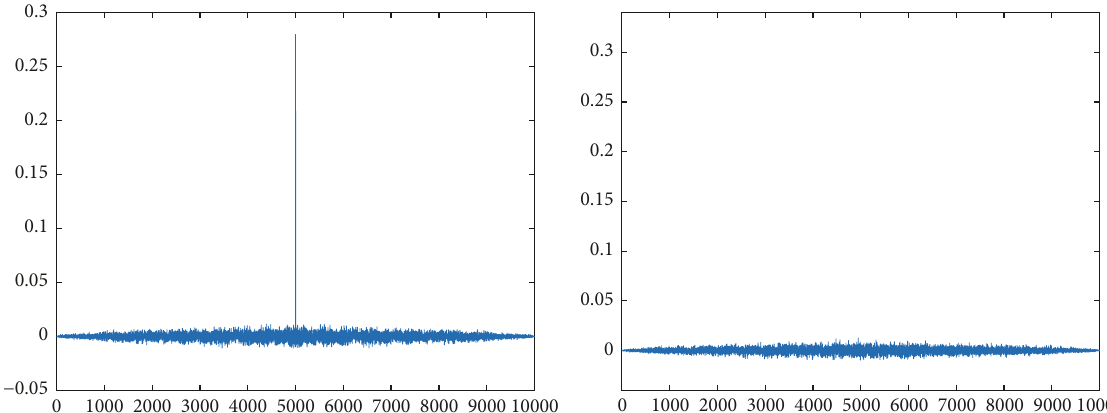
Figure 3: Correlation tests of sequence {𝑏 𝑖 }